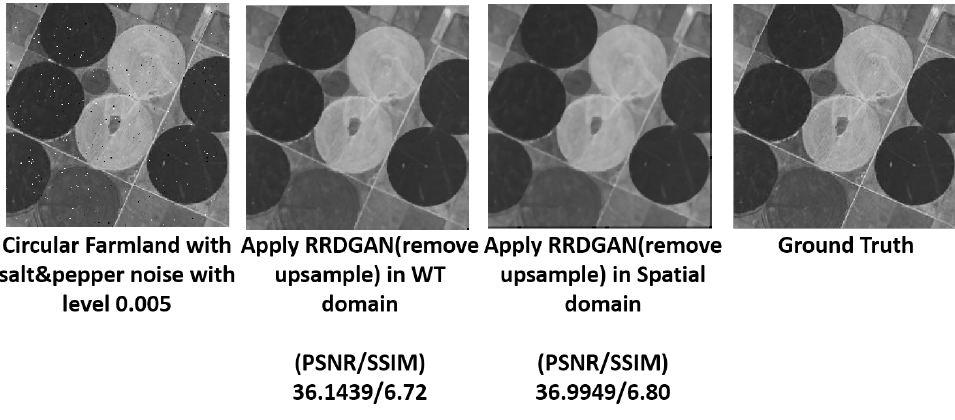
Figure 16. Comparison results of Applying RRDGAN (only denoising) in both WT domain and spatial domain.